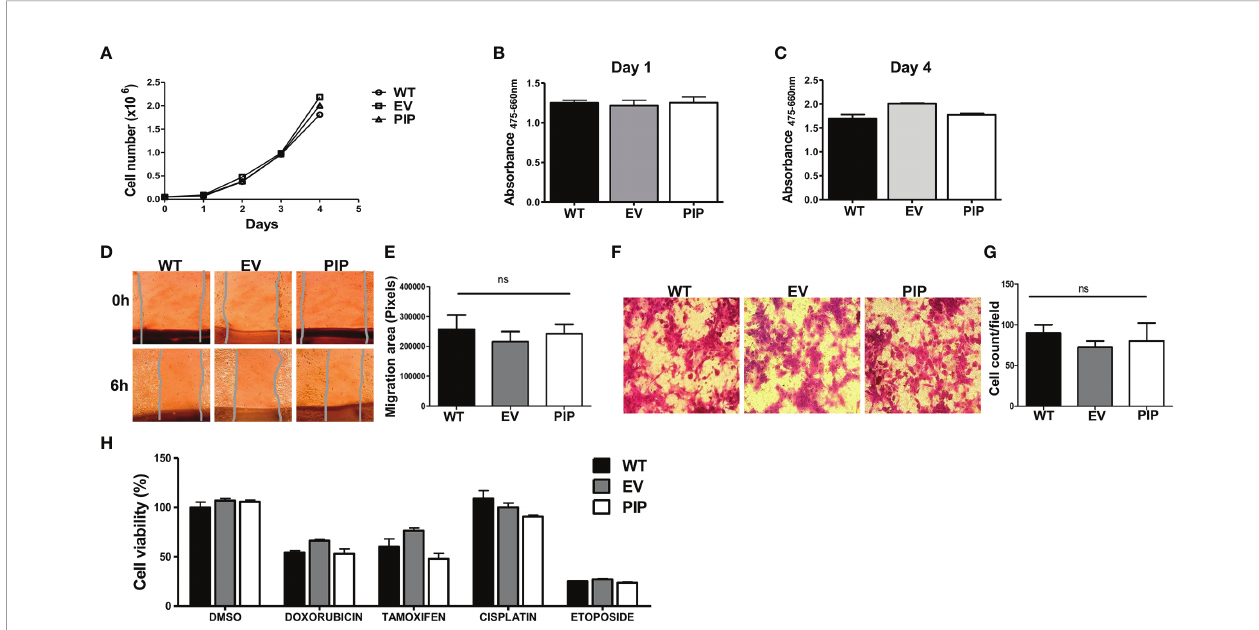
FIGURE 2 | PIP expression does not affect 4T1 cell proliferation, migration, and sensitivity to chemotherapeutic agents in vitro . Wild-type (WT), empty vector (EV) or PIP transduced (PIP) 4T1 cells were seeded in 12 well plates (5 × 10 4 cells/well) and counted daily for 4 days using the TC-10 cell counter. Panel (A) shows the growth curve for WT, EV and PIP transduced 4T1 cells. Panels (B) and (C) show the absorbance values for the different 4T1 cell lines at 1 and 4 days respectively, as assessed by the XTT assay. Cell migration was assessed by wound healing and trans-well migration assays. (D) Representative microscopic images of the wound areas at times 0 and 6 h post scratching. (E) Bar graph depicting the migration areas of the different 4T1 cell lines at 6 h post scratching (n = 4). (F) Representative images of 4T1 cell lines from the trans-well migration assay. (G) bar graph showing the number of migrated cell count per fi eld (n = 3). WT, EV, and PIP transduced 4T1 cells were treated in vitro with different anticancer drugs (doxorubicin, cisplatin, etoposide) as well as tamoxifen for 48 h and cell viability was measured by XTT assay and normalized to DMSO control (H) . All experiments were done in triplicates, and the results are representative of three different experiments with similar outcomes. Results are expressed as mean± SEM; ns, not signi fi cant; two-way analysis of variance was